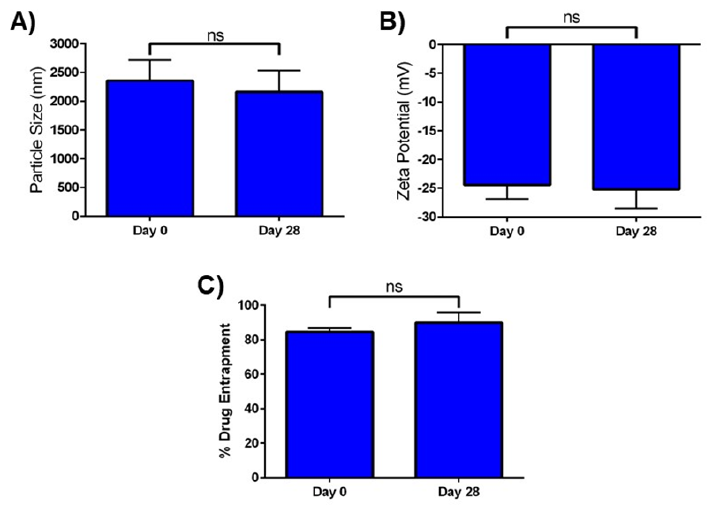
Figure 2. Stability studies of Cela MPs over a span of 28 days at 4 °C measuring ( A ). Particle size (nm), ( B ). Zeta potential (mV), and ( C ). percent drug entrapment. Data represent mean ± SD (n = 3). ns = not significant.